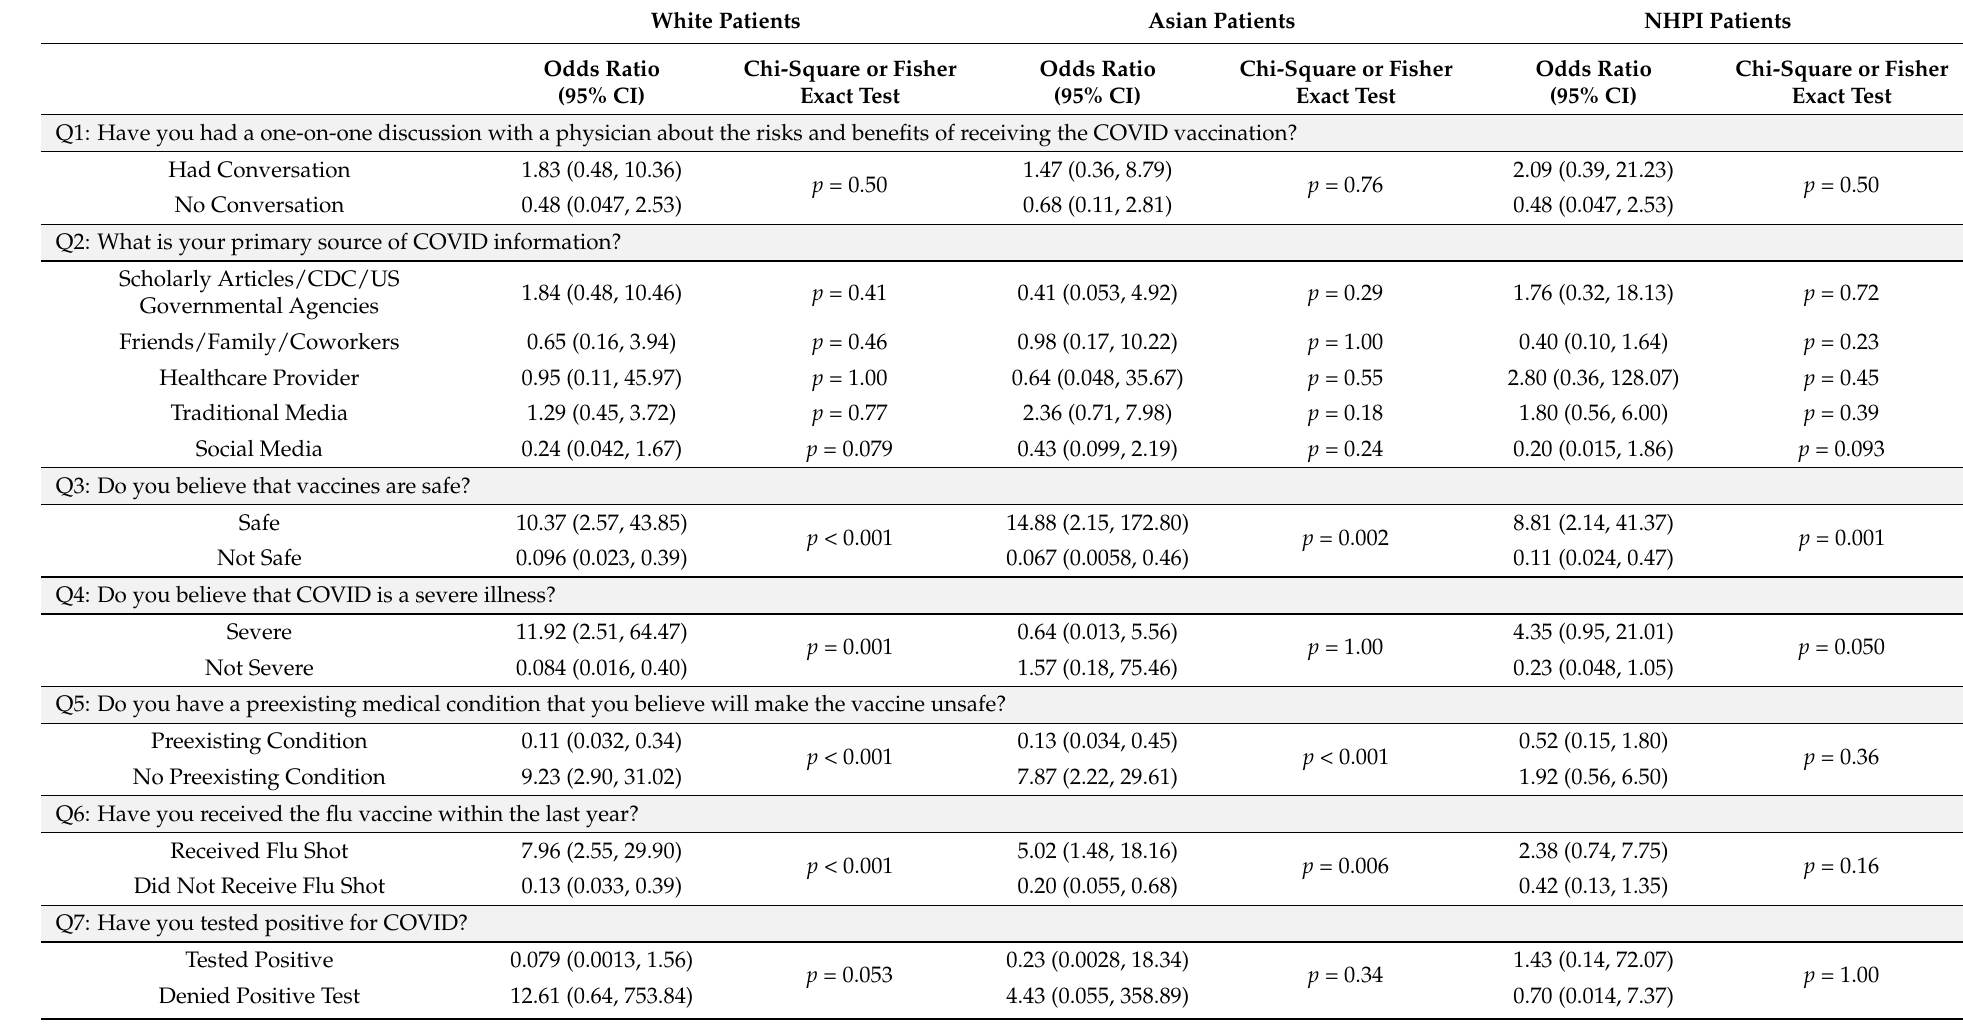
Table 3. Survey question responses stratified by race: crude odds